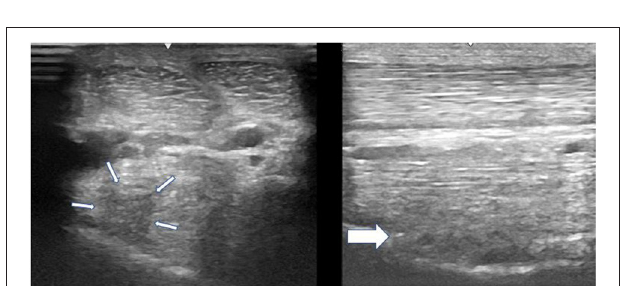
FIGURE 4 | A transverse image of the proximal suspensory ligament about 4cm distal to the head of MTII with a grade 4 lesion. The majority of the ligament’s cross-sectional area (more than 75%) appears diffusely hypoechogenic. In the longitudinal image only a small plantar area of the ligament maintains normal fibre pattern. The dorsal margins of the ligament cannot be distinguished. In transverse images medial is to the left; in longitudinal image proximal is to the